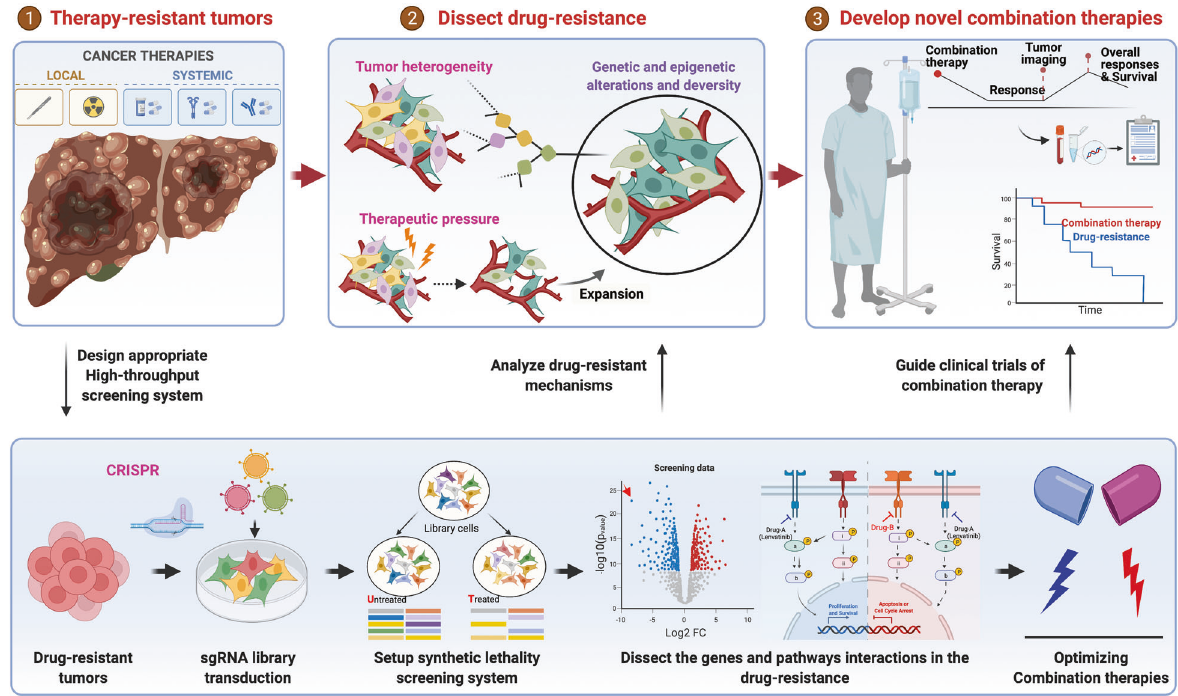
Fig. 1 Rational design of novel clinical trials through CRISPR screening. Majority of the HCC patients receiving systemic therapies either show primary resistance or develop acquired resistance later. With high-throughput CRISPR screening technology, appropriate clinical issue- targeting genetic screens can be designed to elucidate the pathways and mechanisms involved in the drug resistance of HCC and discover new synergistic therapy targets. And the benchtop identi fi ed single or combination therapy targets that can be used to guide small scale clinical trials. The above scenario may provide a new avenue of developing more effective combination therapies. (The schematic was created with